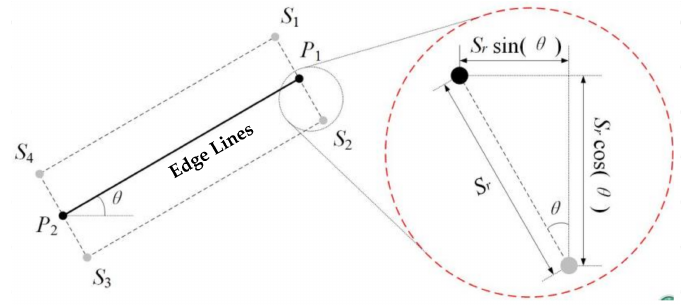
Figure 8. Edge line template window.